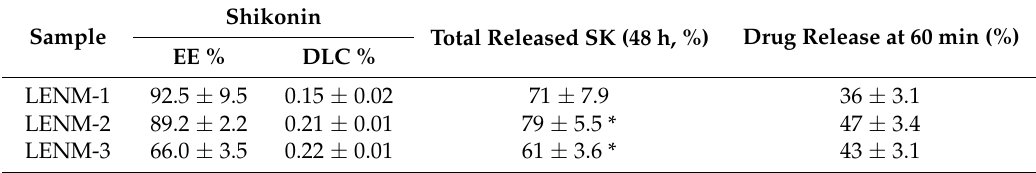
Table 4. Summary of encapsulation efficiency (EE) and drug-loading content (DLC) of LENMs.